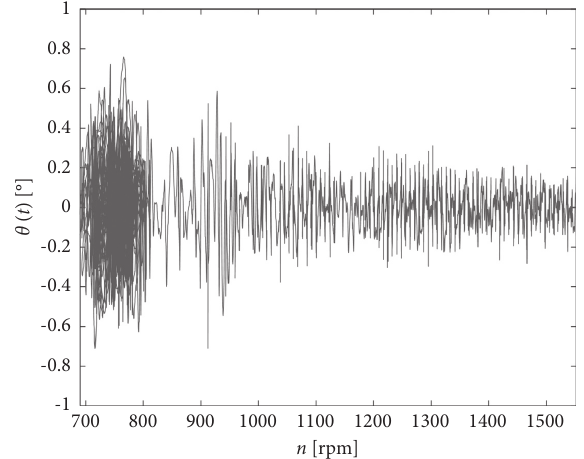
Figure 24: Vibration angle vs. rotation speed of the propeller shaft.